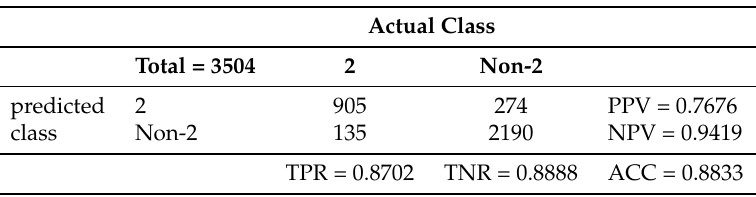
Table 6. Confusion matrix for Subject 1 and Class 2.